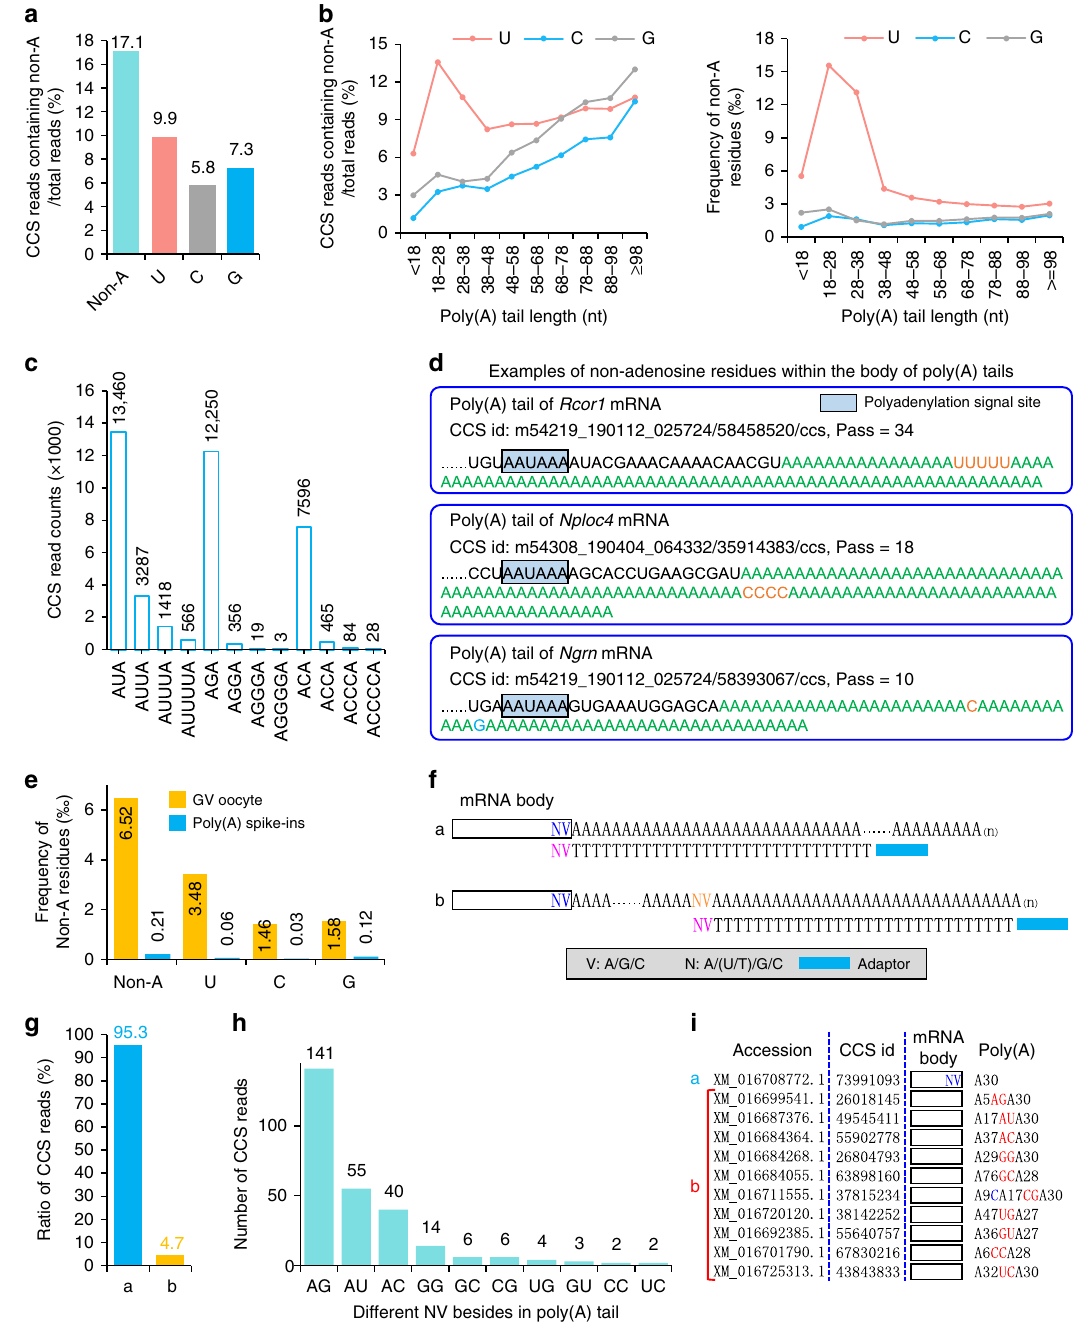
Fig. 5 Widespread non-adenosine residues within the body of poly(A) tails. a Frequency of CCS reads containing internal non-A nucleotides within poly(A) tail. b The ratio of CCS reads containing internal non-A nucleotides (left panel) and frequency of non-adenosine residues in CCS reads of different poly(A) tail length (right panel). c Mono- and oligo-non-adenosine residue (U, C, and G) counts. d Three examples of CCS reads with non-adenosine residues in the body of poly(A) tails, Rcor1 (Pass = 34), Nploc4 (Pass = 18), and Ngrn (Pass = 10). e The frequency of non-A residues in GV oocyte and poly(A) spike-in data. f Hypothetic models of CCS reads with T30VN RT primer anchored at the end of 3 ′ -UTR ( a ) or within the body of poly(A) tails ( b ). g Percentage of two different T30VN RT primer-anchoring models as revealed by CCS reads from Iso-seq data. h The frequency of different NV-anchoring sites detected within the body of poly(A) tails. The number of the detected events are shown above each bar. i Examples of CCS reads with T30VN RT primer anchored at the end of 3 ′ -UTR ( a ) or within the body of poly(A) tails ( b ). The accession number of the CCS reads is shown on the left. The CCS read i.d. is shown in the middle. The CCS read model is shown on the right. The number after A means oligo A with the given number of